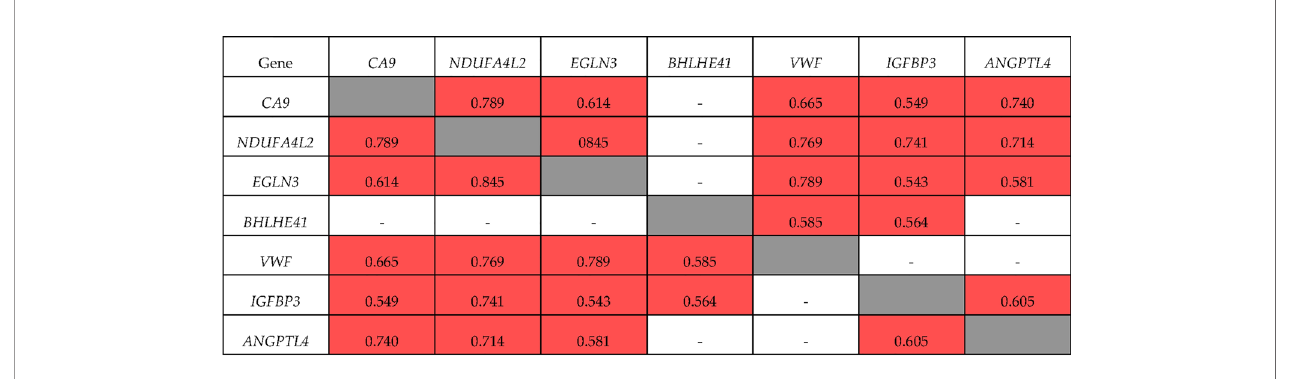
FIGURE 3 | Correlation of gene expression at stage I + II ccRCC. ■ signi fi cant correlation; □ there is no signi fi cant correlation.